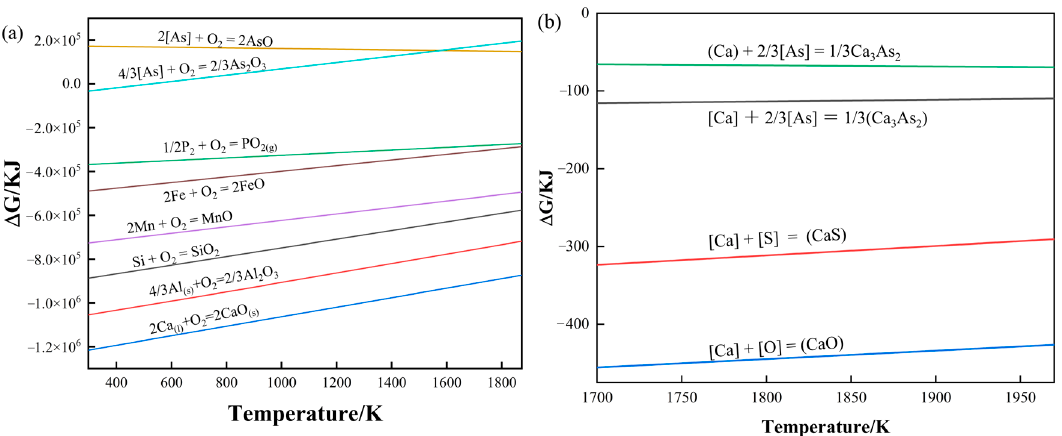
Figure 5. ( a ) Oxygen potential diagram of common elements in molten steel; ( b ) reaction of Ca with O, S, and As elements in molten steel.